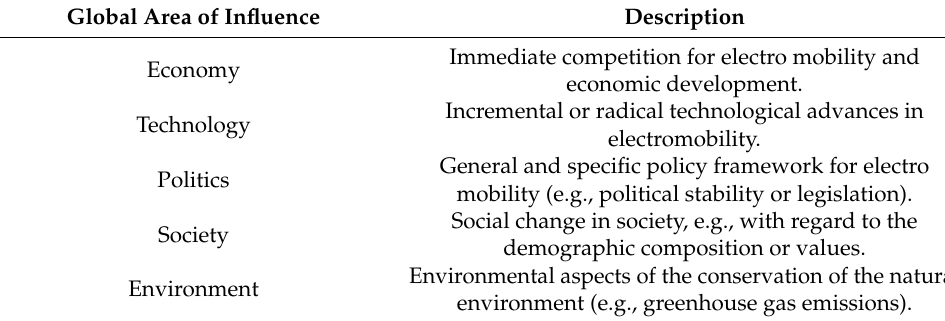
Table 1. Global areas that influence electromobility.